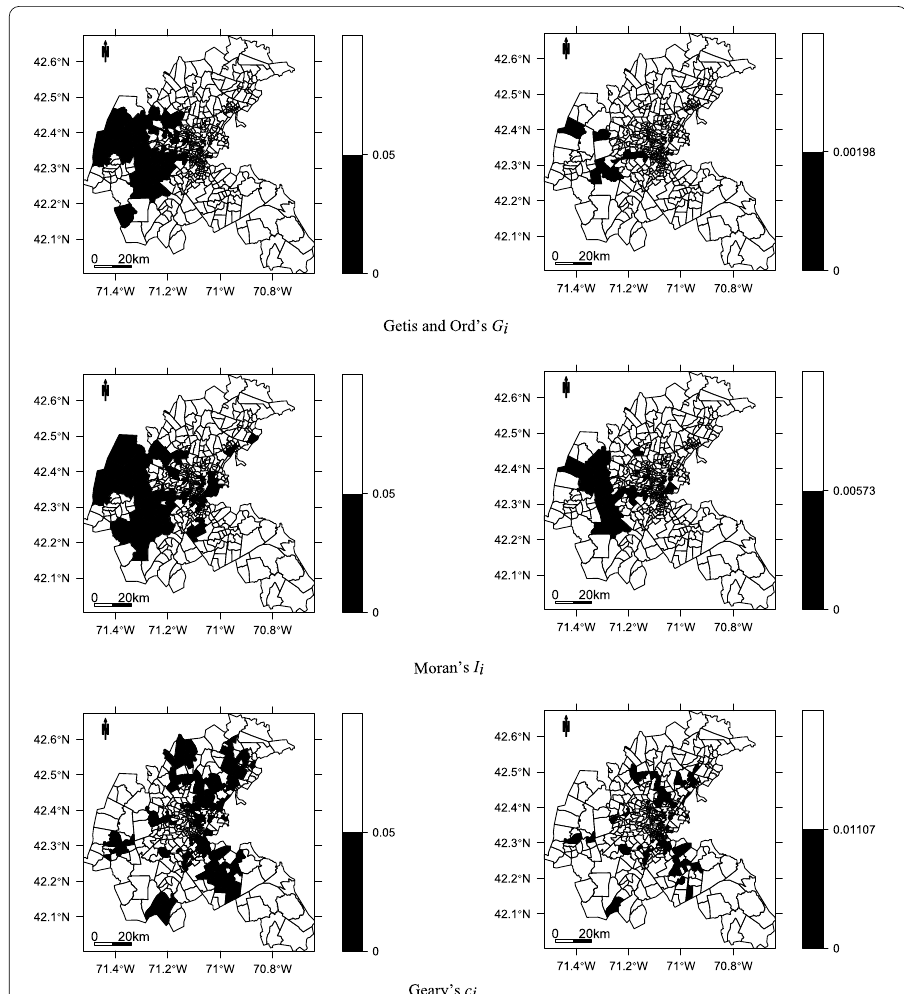
Figure 1 Maps of the categorized p -values for the G i , I i and c i tests. The black areas represent the tracts with the p -values less than the overall significance level α = 0.05 (left-hand column) or less than the corresponding = 0.00198, α I = 0.00573, and α c = 0.01107 (right-hand column) adjusted significance levels α G A A A